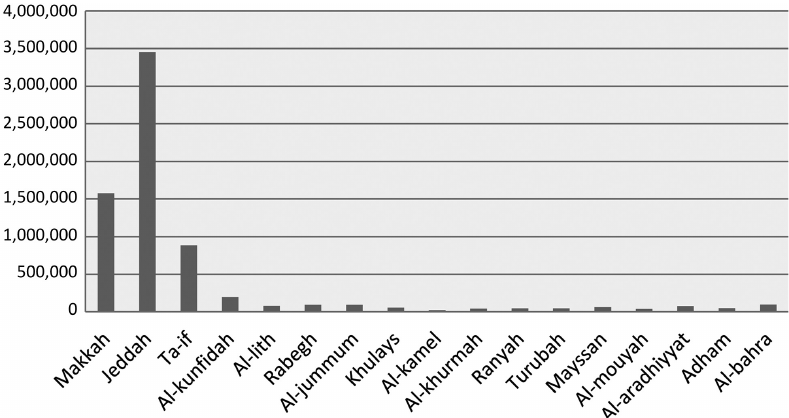
Fig. 3. Geographic distribution of Makkah